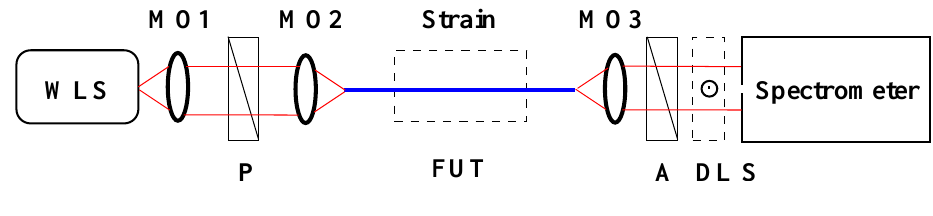
Figure 1. Experimental setup with a fiber under test (FUT) to measure the sensitivity to strain with the remaining components: a white-light source (WLS), microscope objectives 1–3 (MO1, MO2, MO3), a polarizer (P), a fiber under test (FUT), an analyzer (A), a delay line (DL), a spectrometer slit